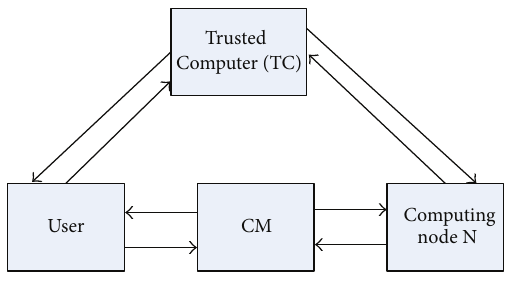
Figure 1: The interactions of the remote